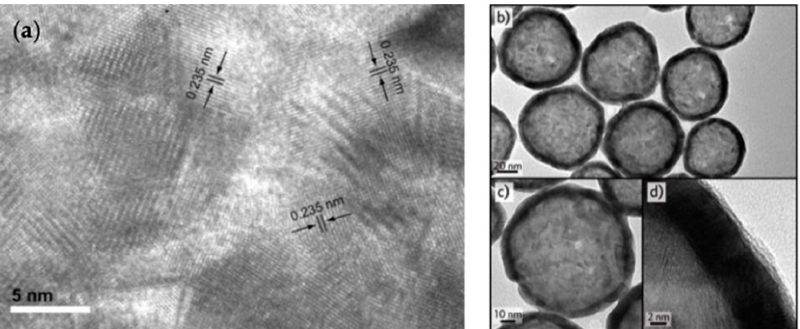
Figure 4. High resolution TEM images of hollow gold nanoshells templated from cobalt nanoparticle templates. ( a ) Lattice image of gold nanoshell showing the characteristic 0.235 nm lattice spacings of crystalline gold. Reprinted with permission from ref. [82], Copyright 2005 American Chemical Society. ( b ) Collection of cobalt-templated HGN showing spherical shapes with dark rims. ( c ) Higher magnification image of nanoshell. The dark rim and lighter interior is consistent with a gold shell structure. ( d ) Close-up of gold shell showing uniform shell thickness.